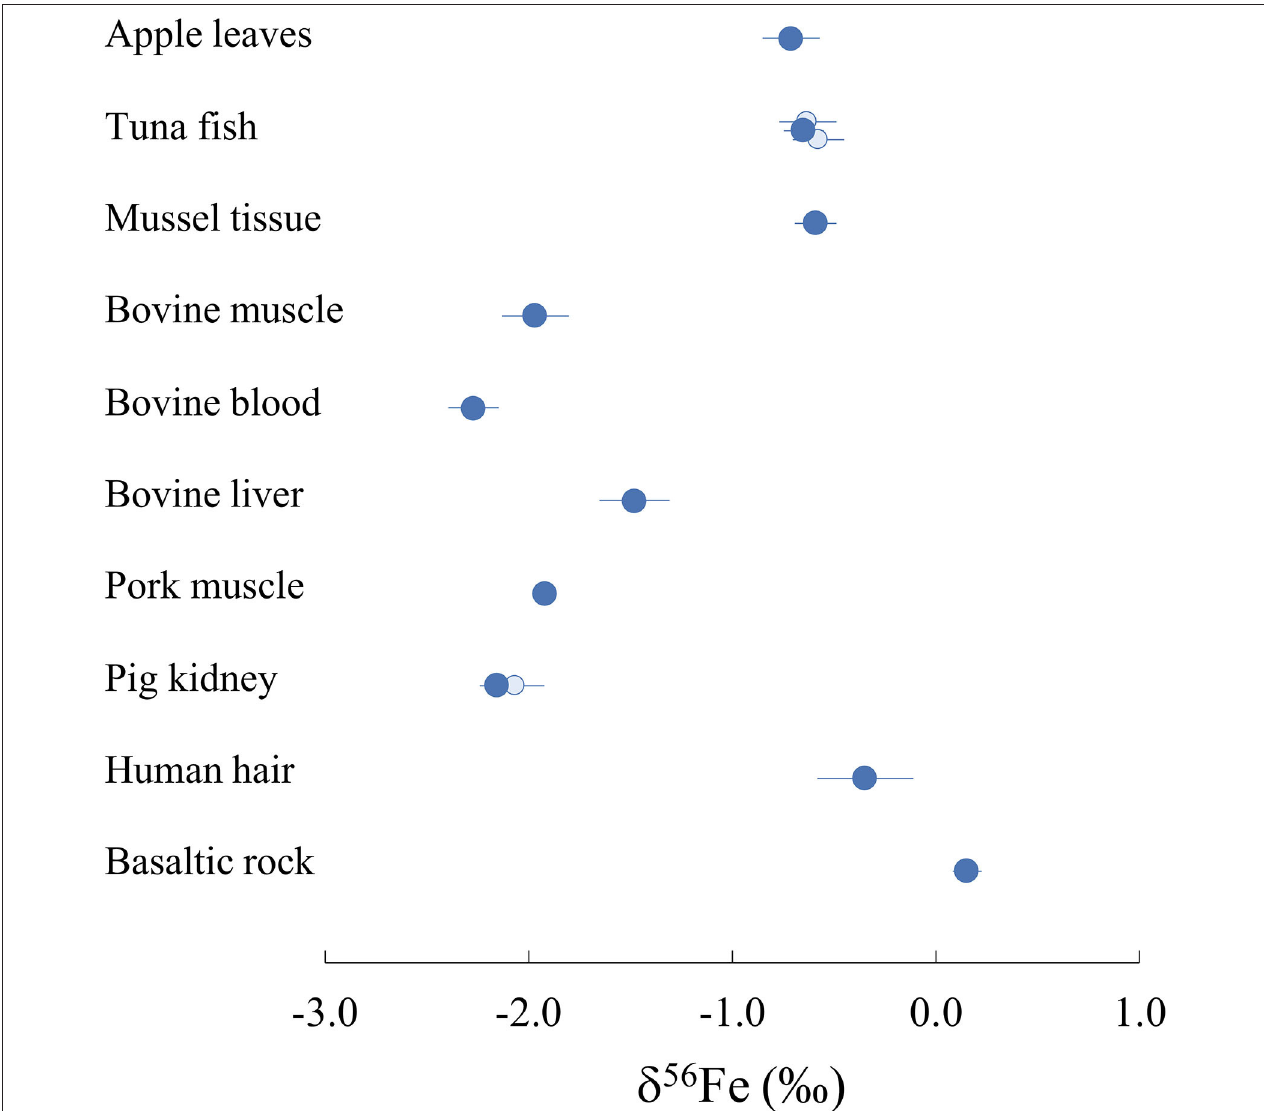
FIGURE 2 | Iron isotope composition δ 56 Fe of all international biological reference materials measured in this study and USGS BHVO-2 rock standard (dark blue). Existing published data are also represented with light blue circles [(51) for pig kidney; (52) for tuna fish] for two of the reference materials measured. Represented error bars correspond to